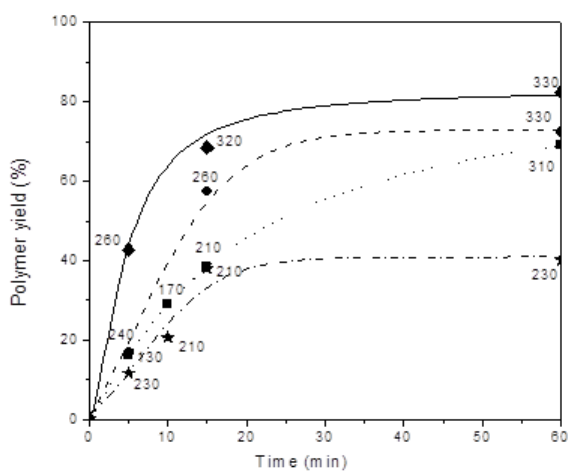
Figure 4. ROMP of cyclooctene over 4.5 / SiO 2 (stars), 4.5 / MCM-41(squares), 4.5 / SBA-15 d = 6.3 nm (circles), 4.5 / SBA-15 d = 11.1 nm (diamonds). Cyclohexane, T = 13 ◦ C, molar ratio cyclooctene / Ru = 500, c 0 cyclooctene = 0.6 mol / L, numbers at individual experimental points give M w of polymer in thousands. Taken from Reference [51] © Elsevier. Reproduced with the permission of Elsevier.